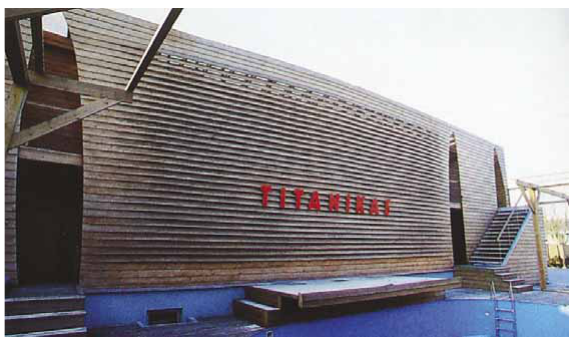
Fig. 9. Guest house “Titanikas”, Šventoji, archit.